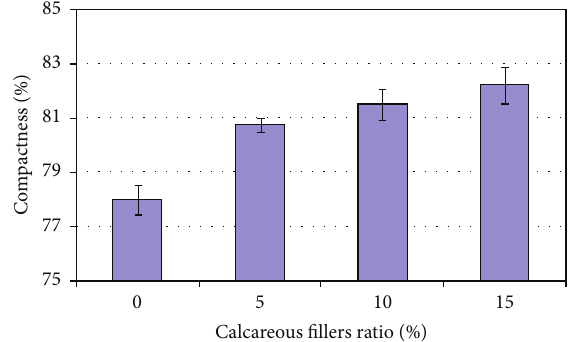
Figure 3: Effects of introducing calcareous fillers on the compact- ness of MPC.